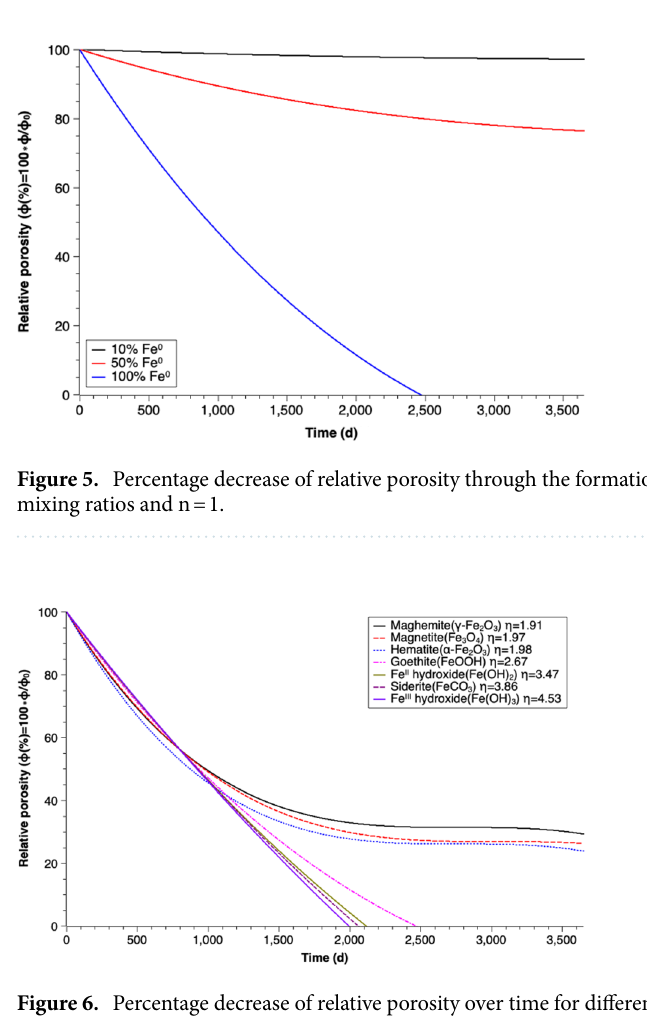
Figure 6. Percentage decrease of relative porosity over time for different corrosion products ( η is the coefficient of volumetric expansion) for n =